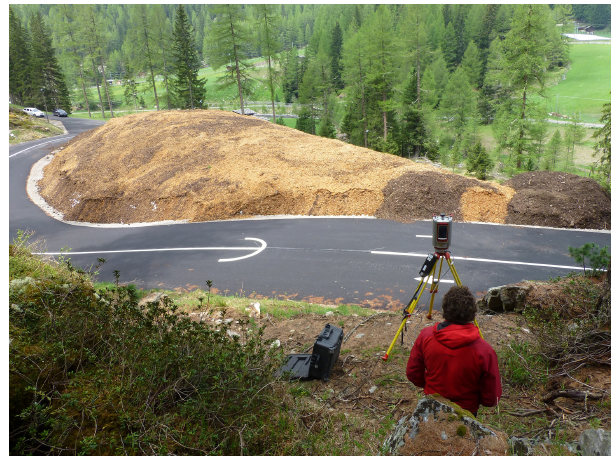
Figure 2. Martell snow heap covered with sawdust and wood chips in spring 2015. The Riegl VZ6000 laser scanner can be seen in the